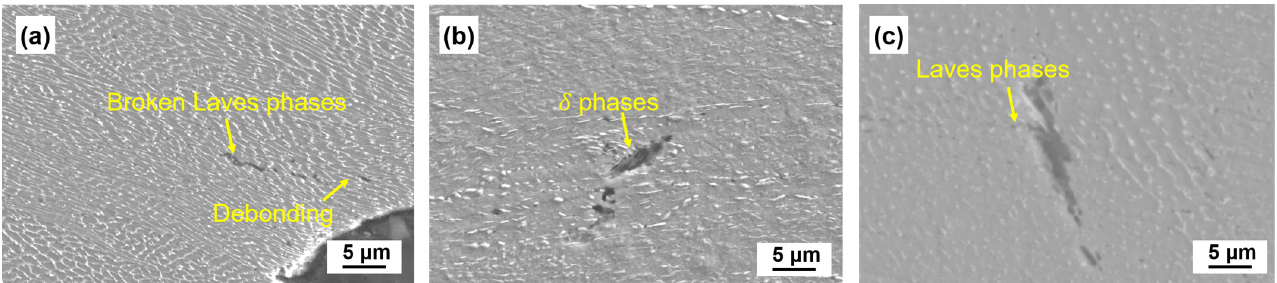
Figure 10. Fracture surfaces of ( a , d ) AB sample, ( b ) and ( e ) SS-treated sample and ( c , f ) DA-treated sample.